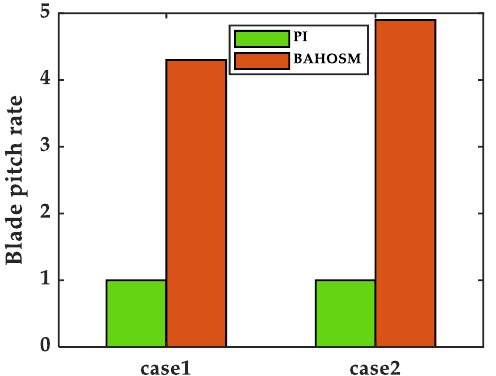
Figure 13. Normalized performance index of blade pitch rate.